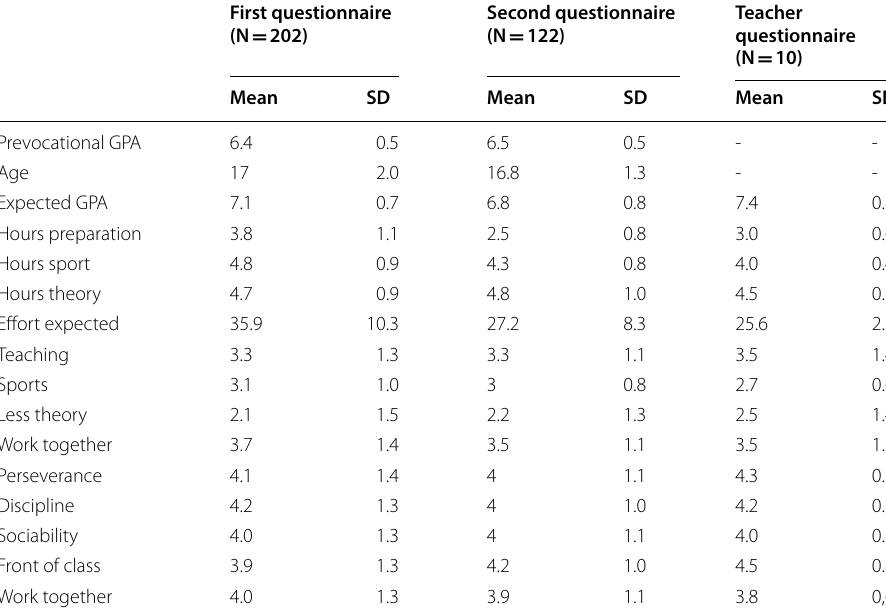
Table 2 Descriptive statistics of the